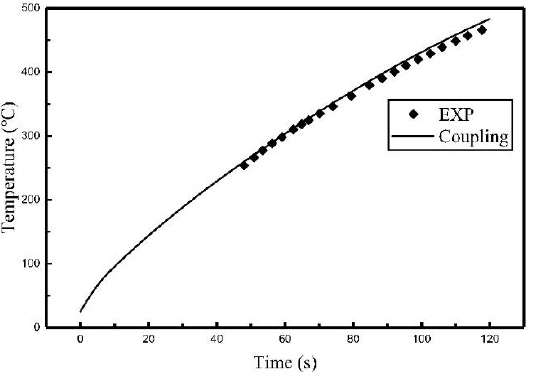
Figure 11. Comparison of the temperature histories of C 1 between the coupling model and the experiment.